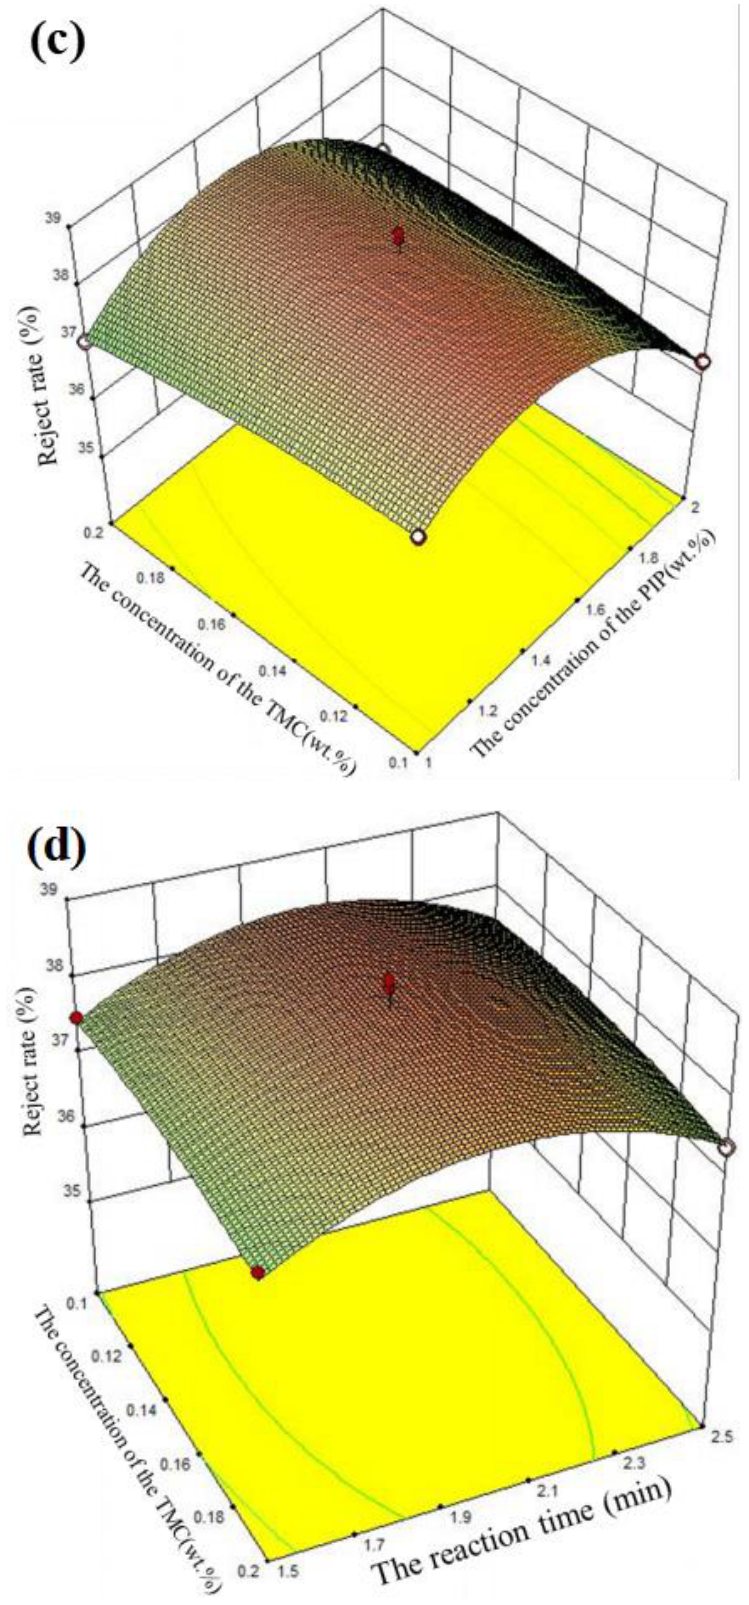
Figure 6. Effects of TMC and PIP concentration on water flux ( a ) and desalination effect ( c ); Effects of TMC concentration and polymerization reaction time on water flux ( b ) and desalination effect ( d